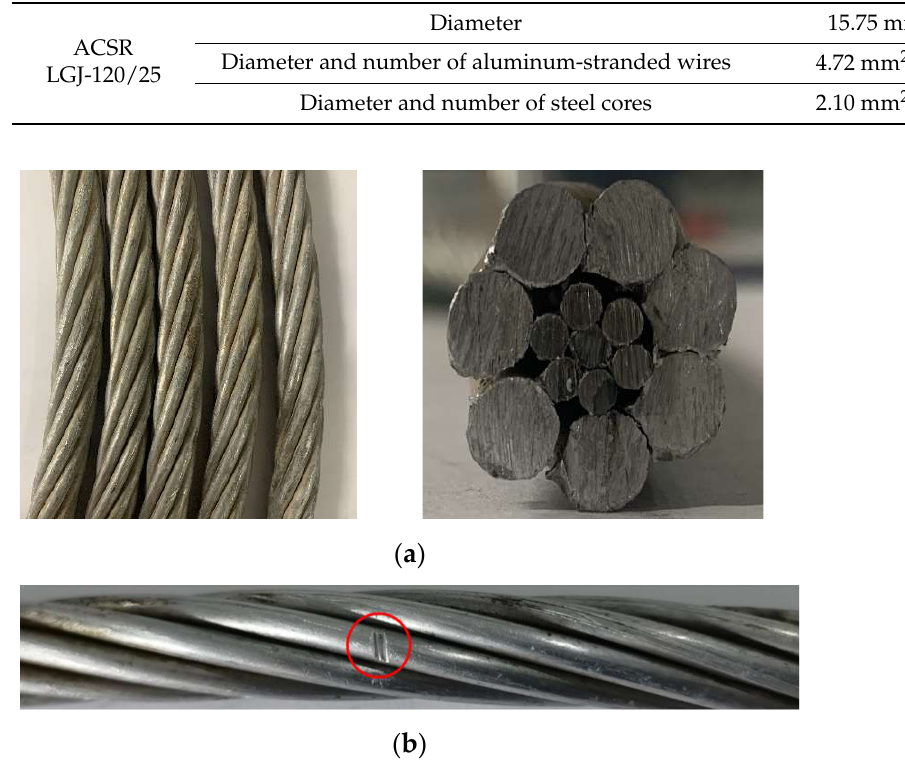
Figure 2. ( a ) Materials used for experiment; ( b ) broken strand defect . Table 1. Parameters of the LGJ-120/25.